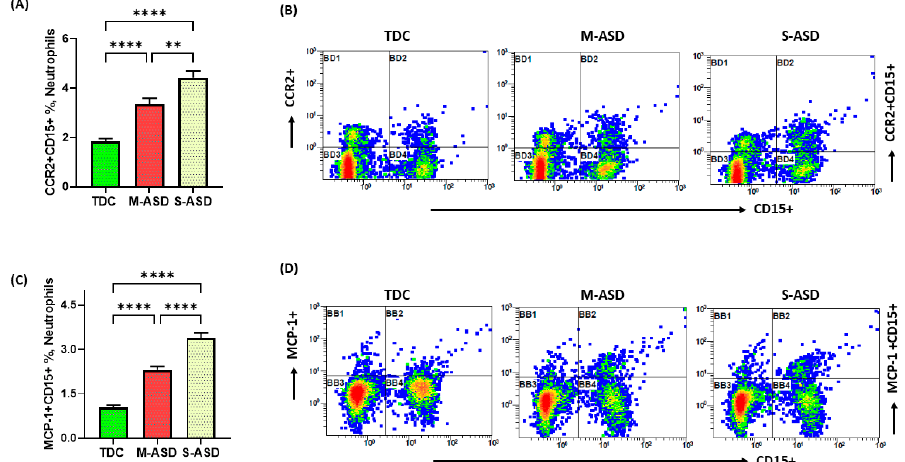
Figure 2. CCR2 and MCP expression in neutrophils of ASD and TDC subjects. ( A ) CCR2 expression in neutrophils, ( B ) illustrative flow diagram displaying CCR2+CD15+ neutrophils, ( C ) MCP-1+ expression in neutrophils, and ( D ) illustrative flow diagram displaying MCP-1+CD15+ neutrophils. Values are presented as mean ± SEM, n = 24–28/group. ** p < 0.01; **** p <